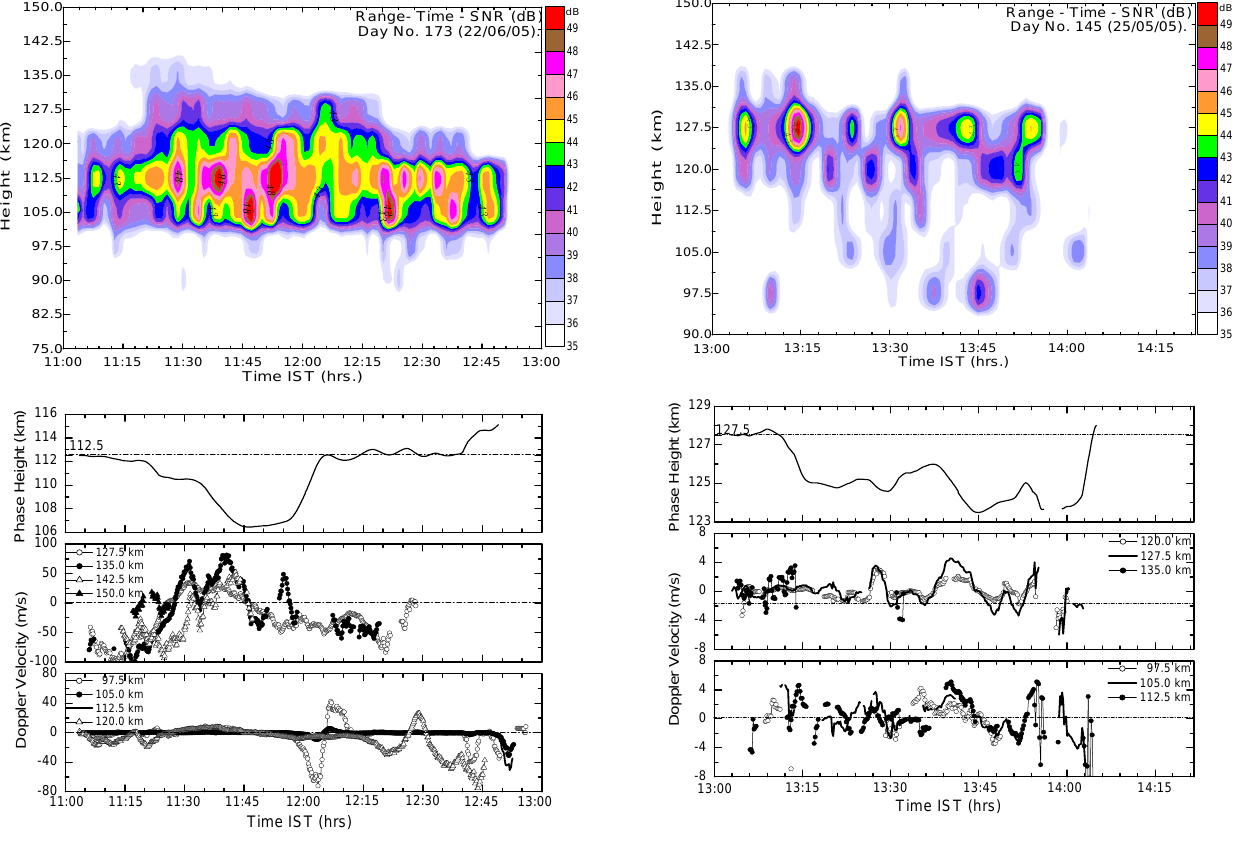
Fig. 2. Top panel shows Range Time Intensity maps for Day no. 173 (22 June 2005). Second panel shows phase height variation of the echo at the range bin where echo intensity is highest. And bottom two panels show the time variations of line of sight Doppler velocity in each range bin.